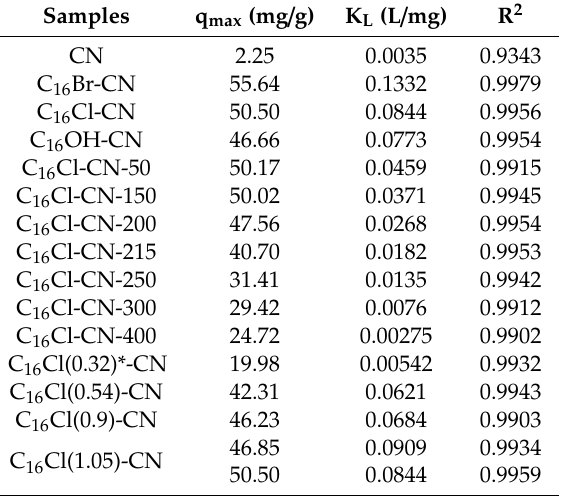
Table 5. Langmuir parameters of eosin removal by the di ff erent organoclays.